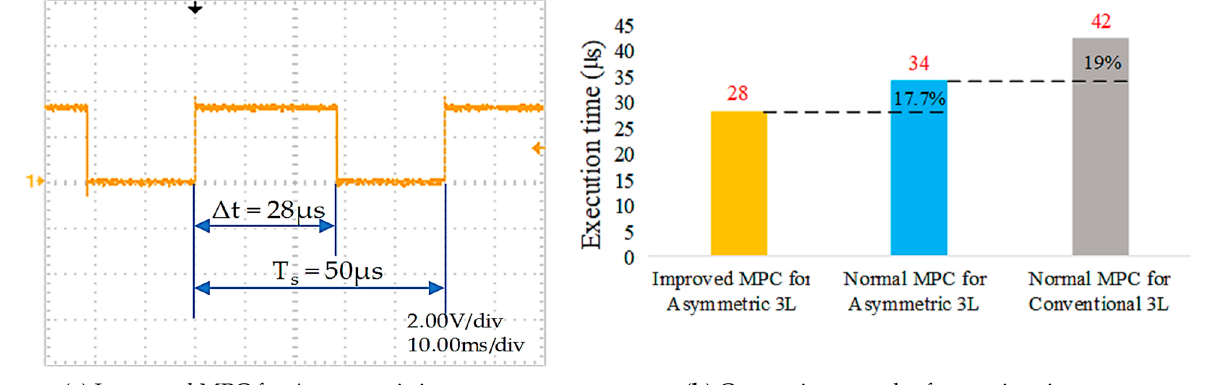
Figure 19. Execution time.